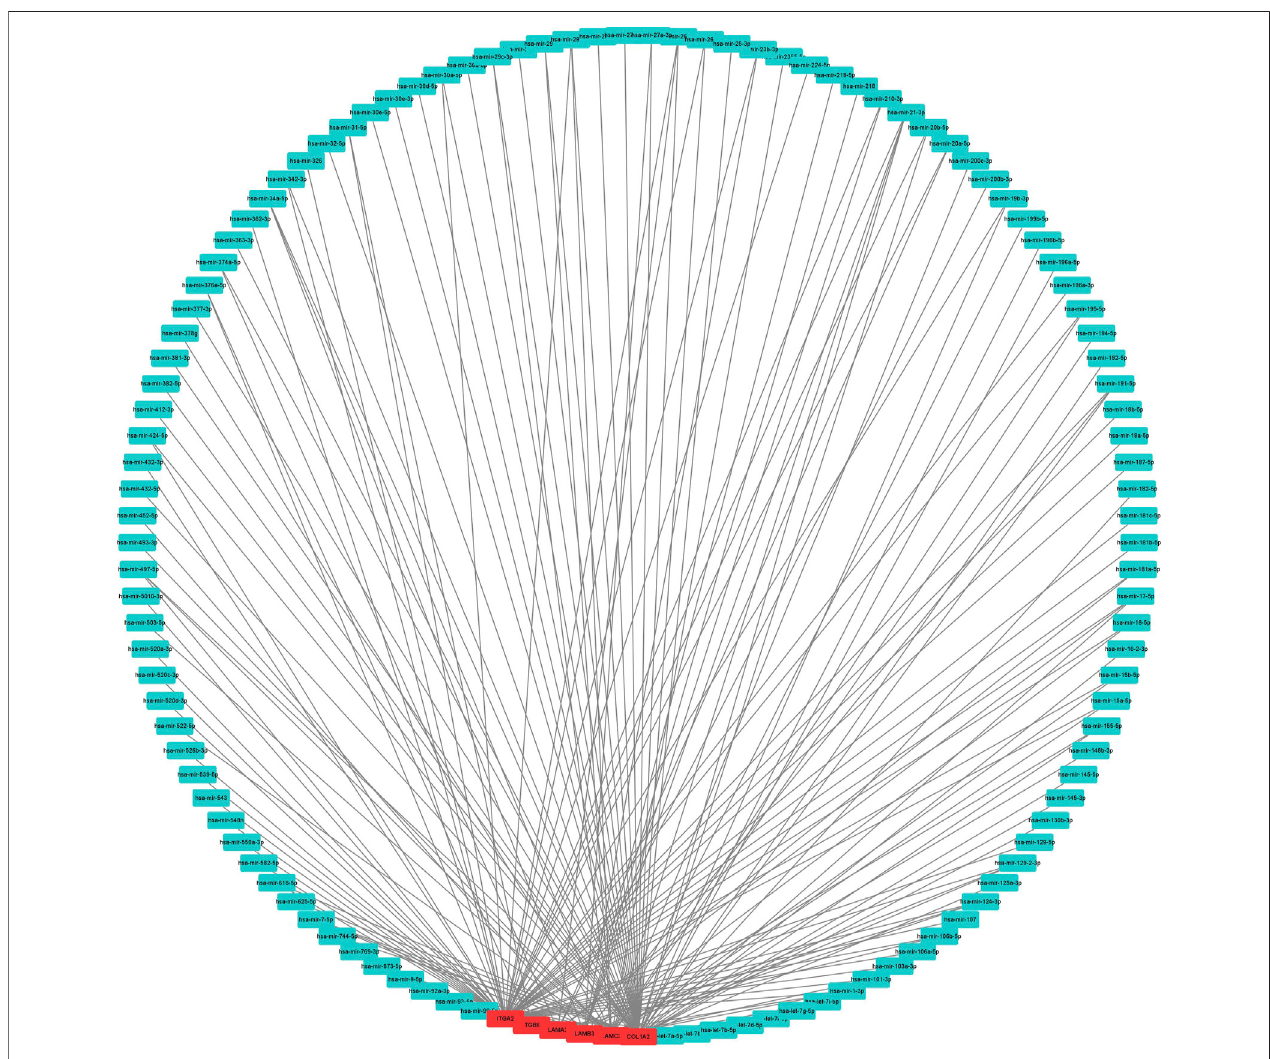
FIGURE 7 | Result of the use of mRNA to reverse-predict miRNA. Red represents highly expressed mRNA, and blue represents miRNA.